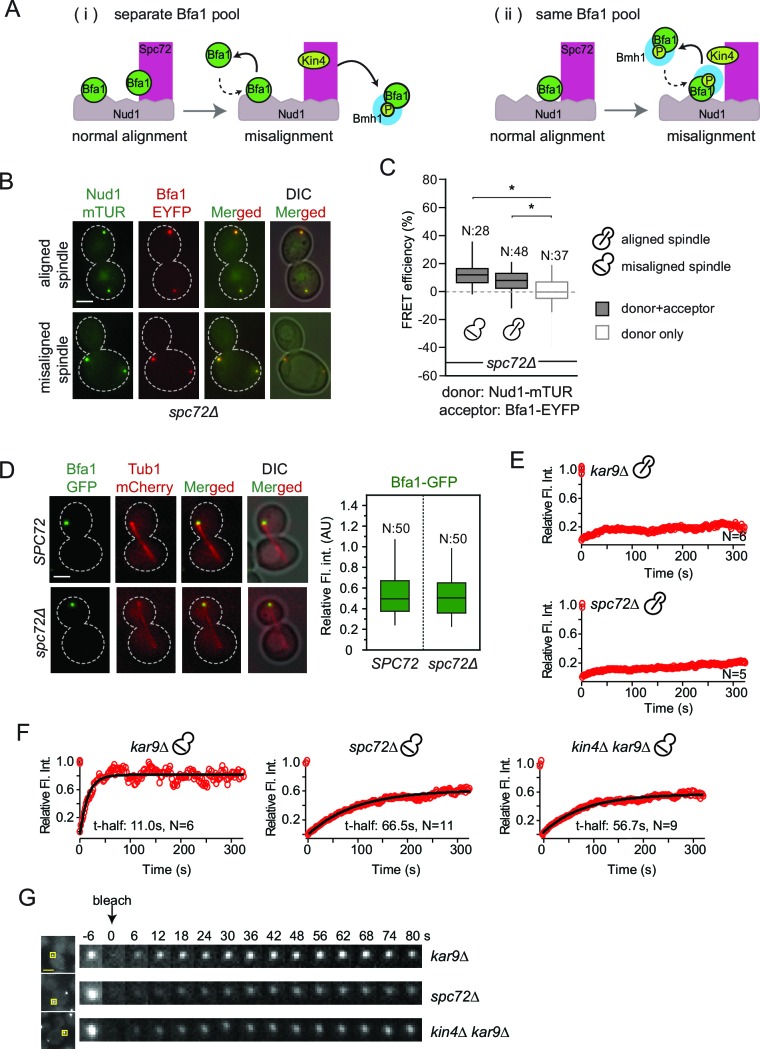
Bfa1-SPB binding dynamics in the absence of Spc72.(A) Schematic representation of two possible mechanisms for Bfa1 binding at the SPB. i: Bfa1 is recruited as two separate pools. ii: Bfa1 associates simultaneously with Nud1 and Spc72. Dashed arrows indicate dynamic binding. (B–C) Representative still images and FRET efficiencies for spc72Δ NUD1-mTUR BFA1-EYFP cells with aligned and misaligned spindle. Box-whisker plot is one out of two technical replicates from the same experiment. N: sample size. Asterisks show significant difference according to student’s t-test (p<0.01). See the accompanying data file for exact p-values (Figure 4—source data 1). (D) Representative still images and mean fluorescence intensities of Bfa1-GFP localized at the dSPB during anaphase in SPC72 (pRS-SPC72 spc72Δ) and spc72Δ cells carrying mCherry-TUB1. Box-whisker plot is one out of two technical replicates from the same experiment. See the source file (Figure 4—source data 2) for the raw data. (E-F) FRAP analysis of Bfa1-GFP at the SPBs in cells with correctly aligned (E) and misaligned spindles (F). The black line depicts the best-fit single exponential curve for each data set. Data represent the mean of “N” sized sample. t-half: half recovery time. The graphs show the average fluorescence recovery curves for the corresponding strains. See the accompanying data file for individual curves and raw data (Figure 4—source data 3 and 4). Data represented in E is one out of two biological replicates. Data for spc72∆ in F is one out of two biological replicates. Data for kar9∆ and kin4∆ kar9∆ comes from one experiment, whose results are in concordance with published data (Caydasi et al., 2014; Caydasi and Pereira, 2009). (G) Representative still images of (F). Photobleached SPB is marked with squares. Time-lapse series show 3-fold enlarged photobleached regions at the indicated time points. Time zero is the first image taken after photobleaching. Scale bar: 3 μm.DOI:
http://dx.doi.org/10.7554/eLife.14029.02810.7554/eLife.14029.029Figure 4—source data 1.Raw data and the calculated FRET efficiencies of the Nud1-Bfa1 pair in spc72∆ cells with normally aligned or misaligned spindles (source data for Figure 4C).DOI:
http://dx.doi.org/10.7554/eLife.14029.02910.7554/eLife.14029.030Figure 4—source data 2.Raw and normalized mean fluorescence intensities of Bfa1-GFP at SPBs of spc72∆ and SPC72 cells (source data for Figure 4D).DOI:
http://dx.doi.org/10.7554/eLife.14029.03010.7554/eLife.14029.031Figure 4—source data 3.Raw and normalized FRAP data of Bfa1-GFP at the SPBs of spc72∆ and kar9∆ cells with normally aligned spindles.FRAP curves for individual cells are also presented (source data for Figure 4E).DOI:
http://dx.doi.org/10.7554/eLife.14029.03110.7554/eLife.14029.032Figure 4—source data 4.Raw and normalized FRAP data of Bfa1-GFP at the SPBs of spc72∆ and kar9∆ cells with misaligned spindles.FRAP curves for individual cells are also presented (source data for Figure 4F).